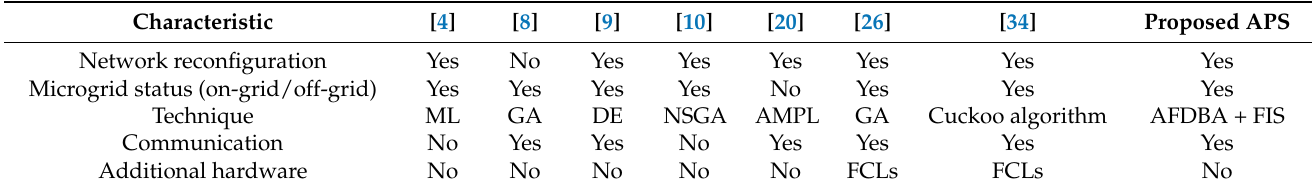
Table 3. Comparison among the proposed APS and other similar solutions available in the